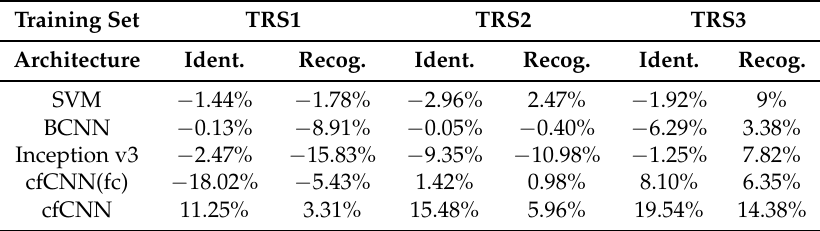
Table 3. A performance evolution of different network architectures on the DR dataset relative to the architecture of Rodgers et al. Includes results for the recognition and identification tasks.